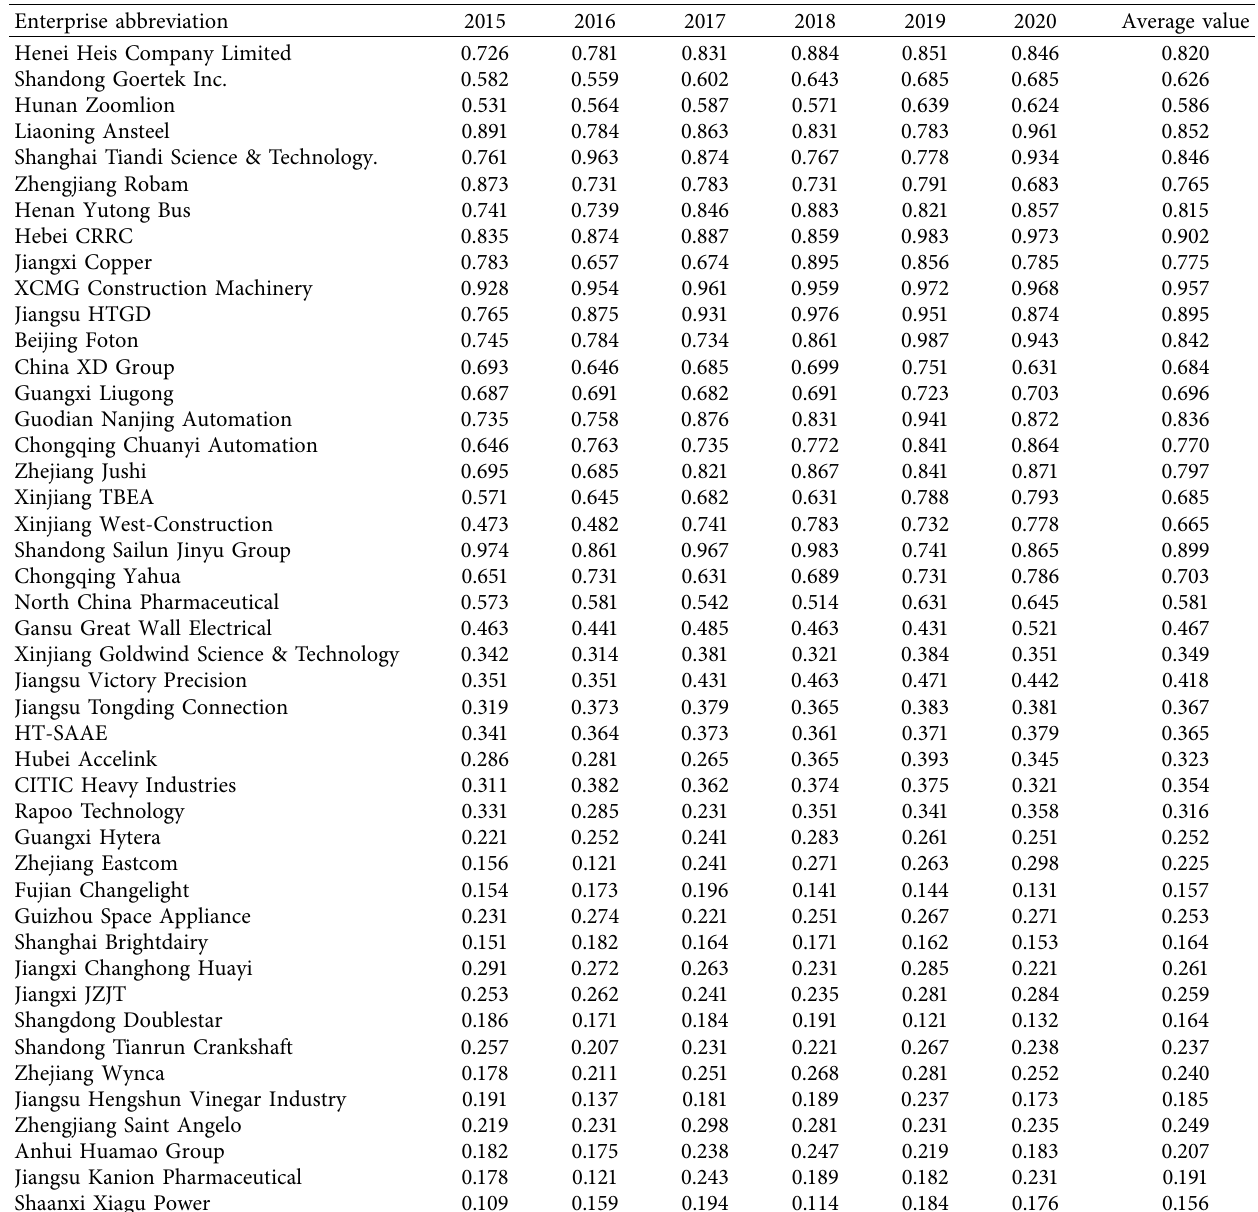
Table 2: Innovation efficiency of 45 IM enterprises from 2015 to 2020.